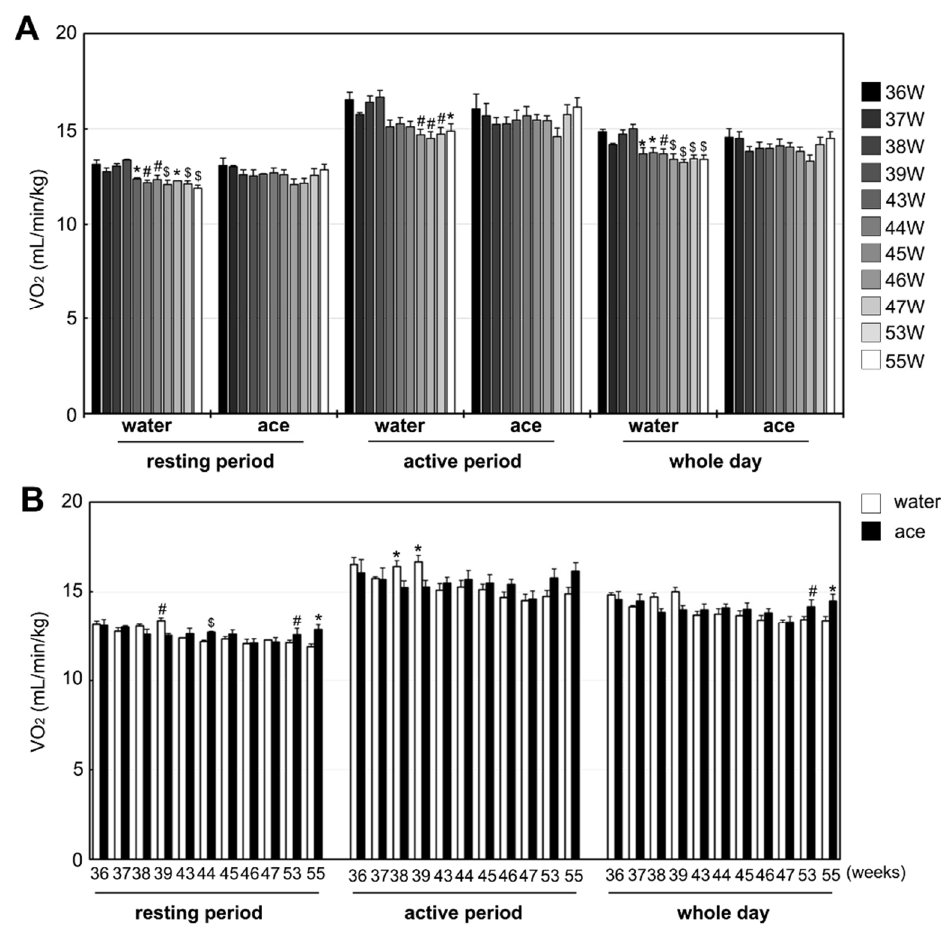
Figure 1. Oxygen consumption (VO 2 ) of Sprague Dawley (SD) rats in the water and acetic acid (ace) groups from 36 to 55 weeks of age ( A ), and comparison between VO 2 of SD rats in the water and ace groups ( B ) during the resting, active, and whole-day periods. The resting period was 10:00 am to 8:00 pm, the active period was 8:00 pm to 8:00 am, and the whole-day period was from 10:00 am to 8:00 am. ( A ): Results were analyzed with one-way ANOVA followed by the Tukey–Kramer post hoc test for multiple comparisons. * p < 0.05, # p < 0.01, $ p < 0.001, statistically significant versus the value obtained at 36 weeks of age. ( B ): Results were analyzed with Student’s t -test. * p < 0.05, # p < 0.01, $ p < 0.001, statistically significant versus the value of water group. Values shown represent means ± SE for 4 – 5 rats.